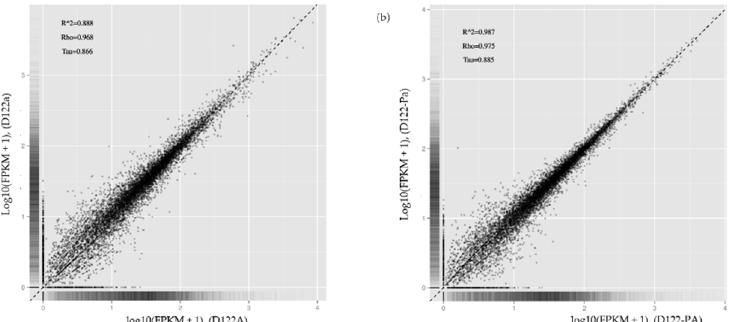
Figure 8. Correlation check of RNA-seq. ( a ) Correlation check of samples D122a and D122A; ( b ) Correlation check of samples D122-Pa and D122-PA. R^2 is the square of the Pearson Correlation Coefficient, Rho is the Spearman Correlation Coefficient and Tau is the kendall-tau Correlation Coefficient.